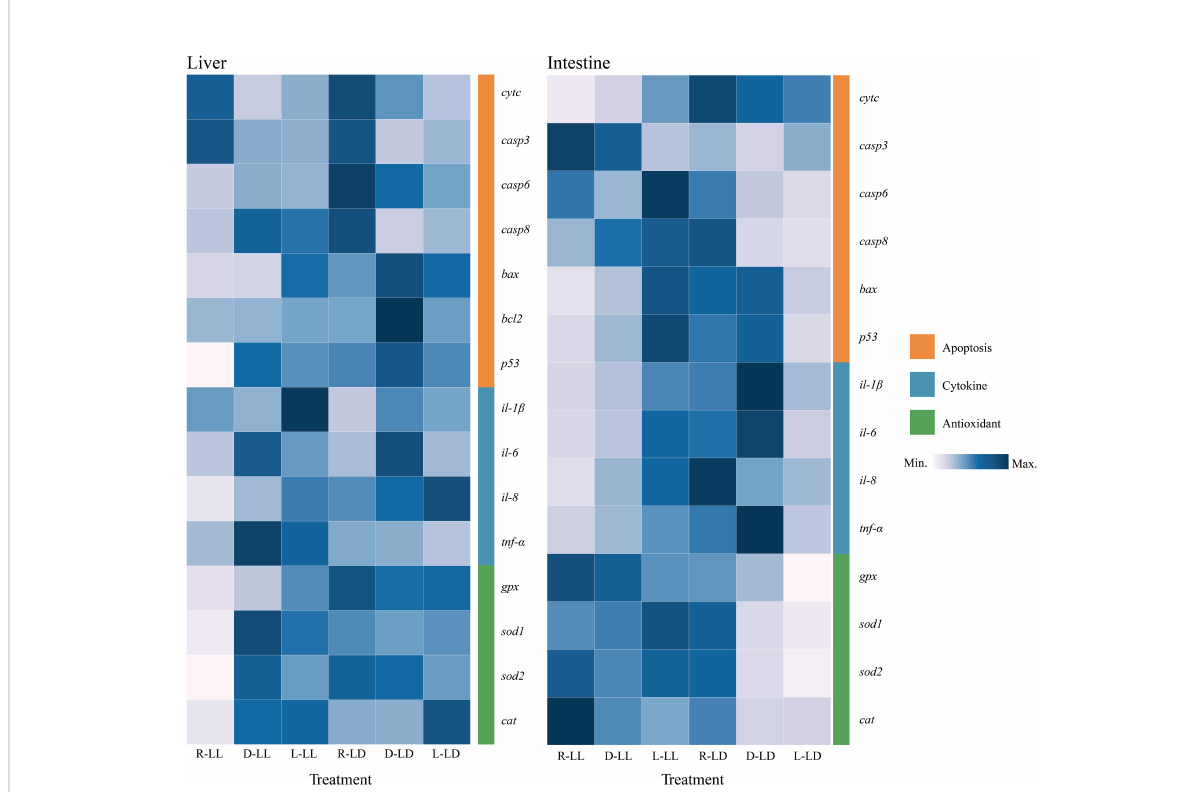
FIGURE 7 Liver and intestinal apoptosis, cytokine, and antioxidant-related gene expression of juvenile Oncorhynchus mykiss under different experimental treatments (n=6). R: random feeding, D: mid-dark stage feeding, L: mid-light stage feeding, LL: 24L: 0D, LD: 12L: 12D. cytc : Cytochrome c, casp3 : Caspases 3, casp6 : Caspases 6, casp8 : Caspases 8, bax : Bcl2-associated X, bcl-2 : B-cell lymphoma-2, p53 : Tumor suppressor p53, il-1 b : Interleukin-1 b , il-6 : Interleukin-6, il-8 : Interleukin-8, tnf- a : Tumor necrosis factor- a , gpx : Glutathione peroxidase, sod1 : Cytosolic Cu/Zn